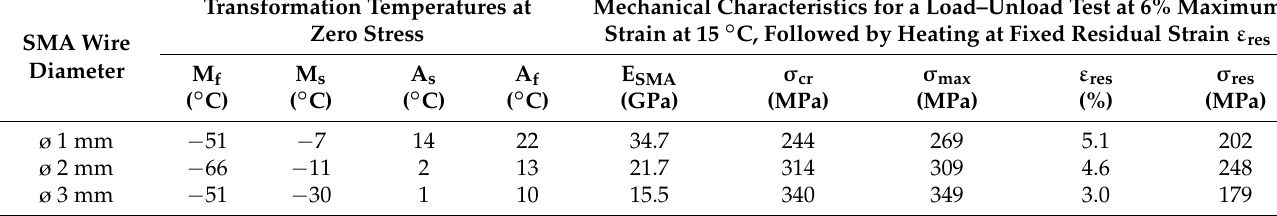
Table 1. Properties of the three shape memory alloy (SMA) wires: transformation temperatures and mechanical properties from [21,23]. Transformation Temperatures at SMA Wire Diameter